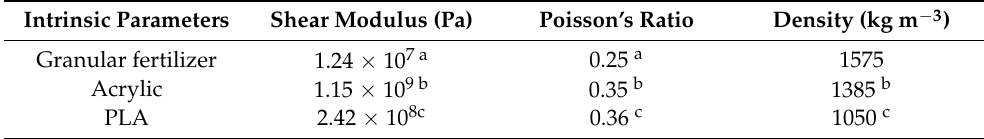
Table 1. Mechanical properties of the materials.